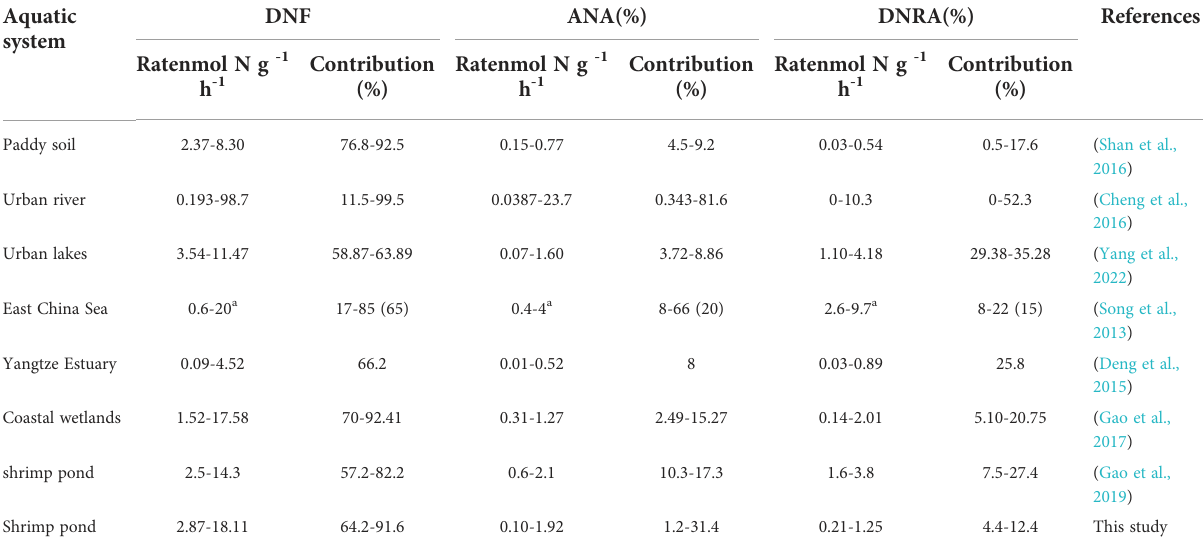
TABLE 4 Contributions of Denitri fi cation, ANAMMOX, and DNRA to total nitrate reduction in our study and other aquatic ecosystems. Aquatic